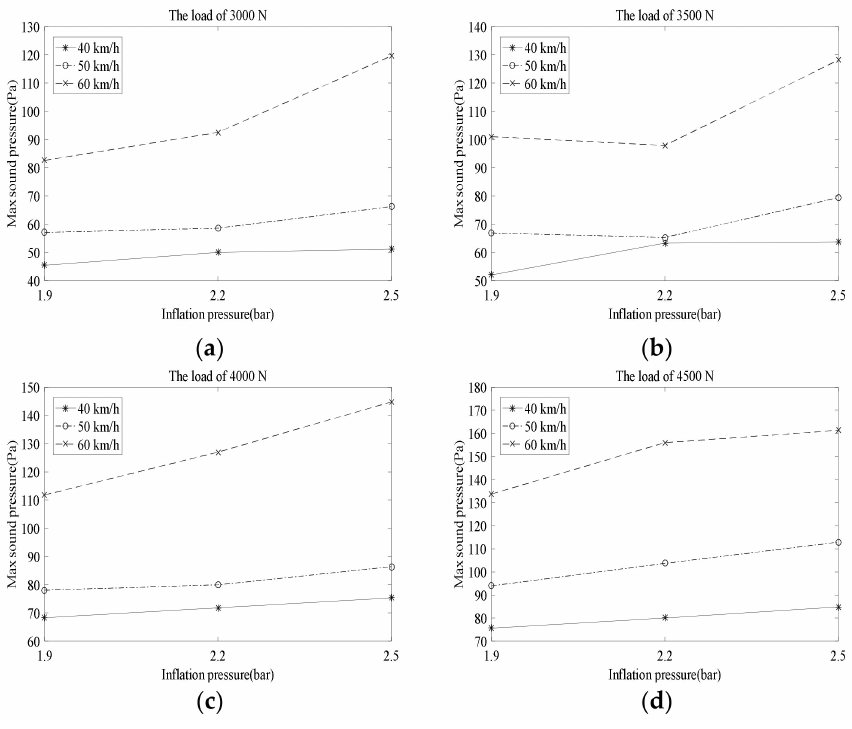
Figure 12. Variation of maximum acoustic pressure amplitudes with inflation pressures: ( a ) For the load of 3000 N; ( b ) For the load of 3500 N; ( c ) For the load of 4000 N; ( d ) For the load of 4500 N.